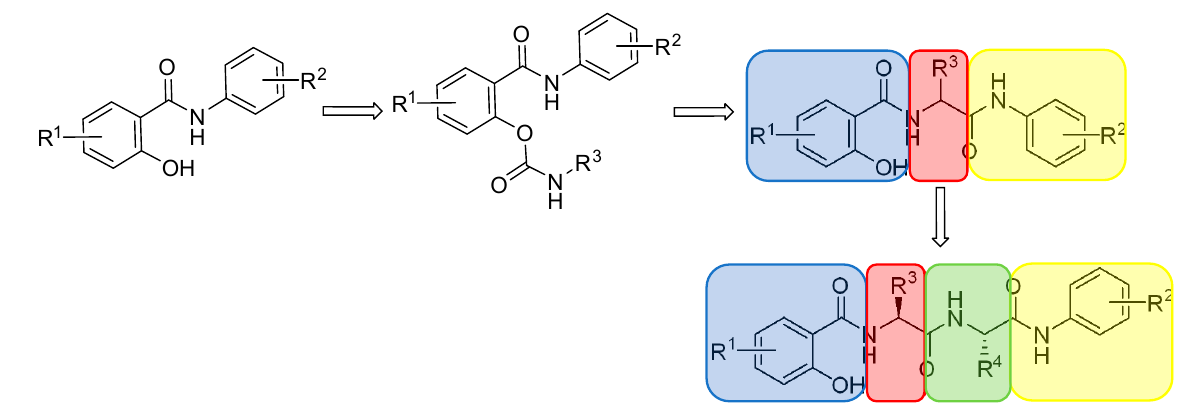
Figure 1. Design of diamides and triamides (peptidomimetics) derived from salicylanilide.